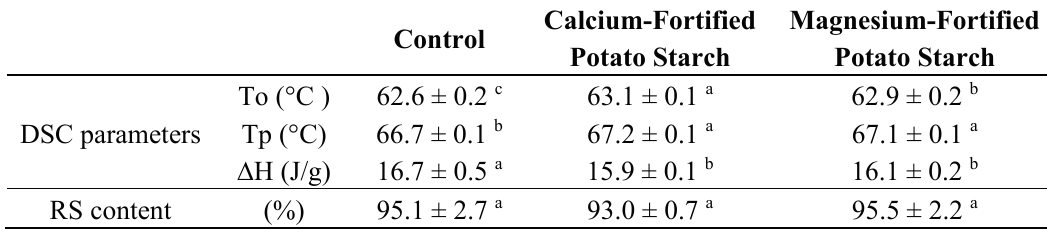
Table 1. DSC gelatinization properties and RS content of the calcium- and magnesium-fortified potato